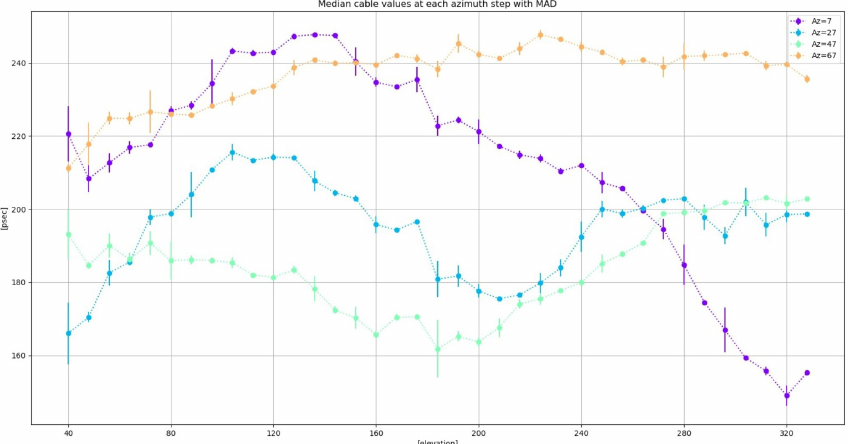
Figure 27. Median values of cable delay measurements at each azimuth step from loops at different elevations. The error bar represents the